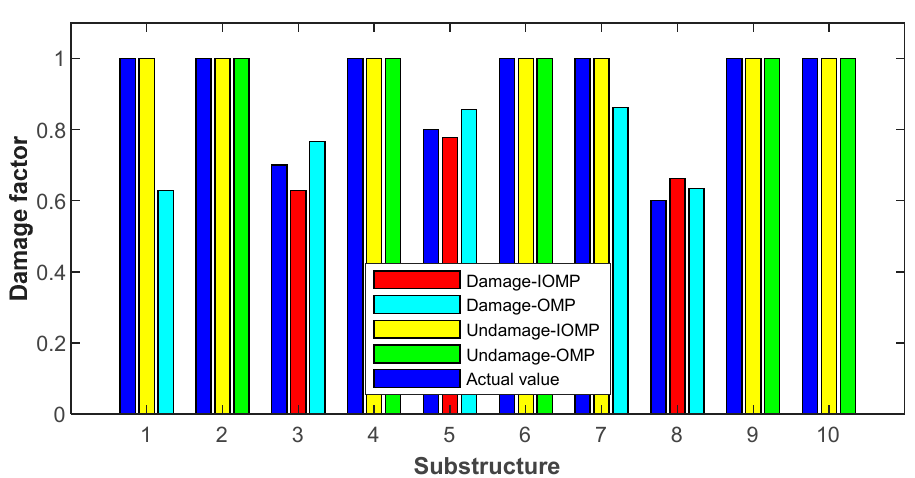
Figure 7. Identification results obtained using OMP and IOMP method (Gaussian kernel regression model).